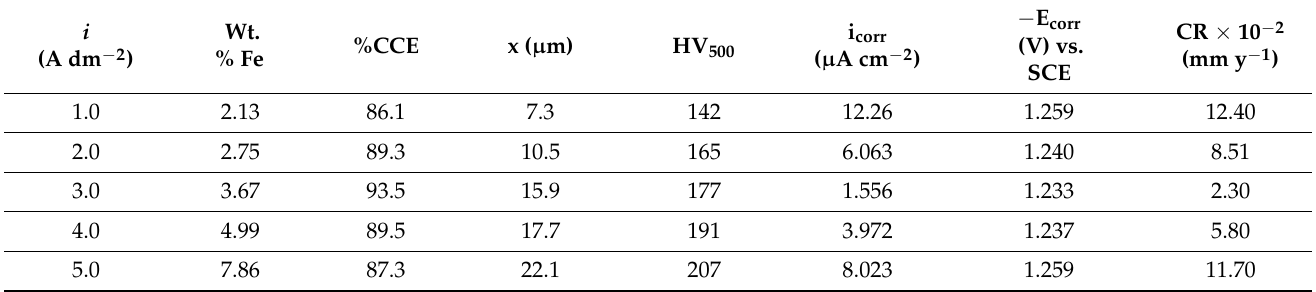
Table 2. Effect of current density on wt. % Fe, hardness, thickness, and corrosion resistance of the